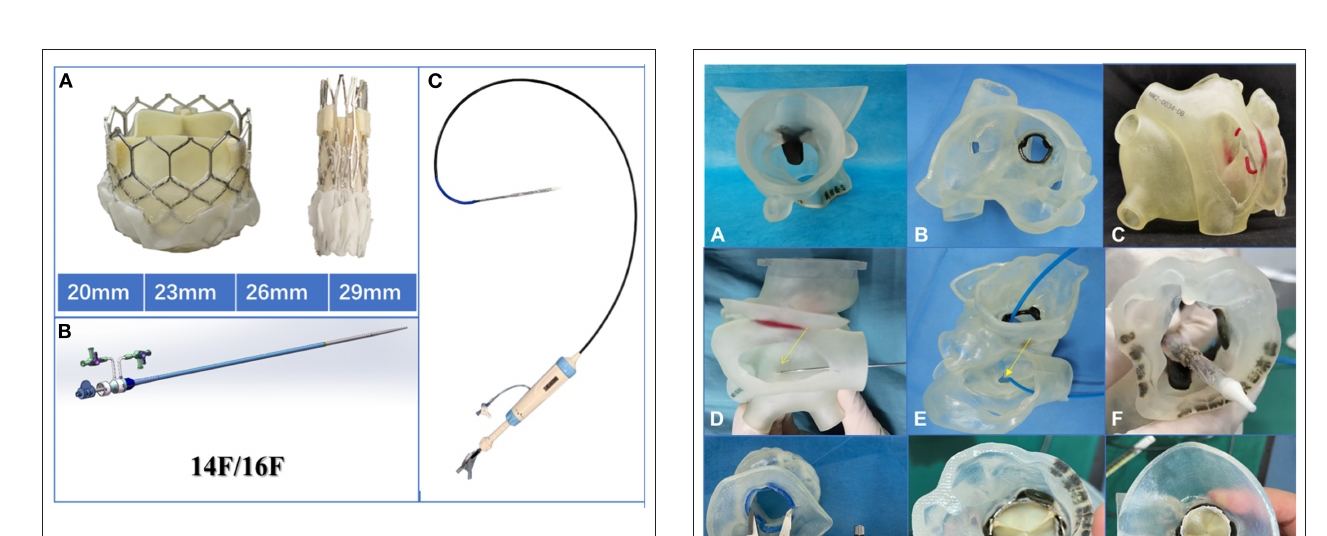
FIGURE 2 | Characteristics of the Prizvalve balloon-expandable valve. (A) The 4 main sizes: 20, 23, 26, and 29mm. (B) The 2 types of delivery systems (14/16F). (C) The adjustable curved introducer.